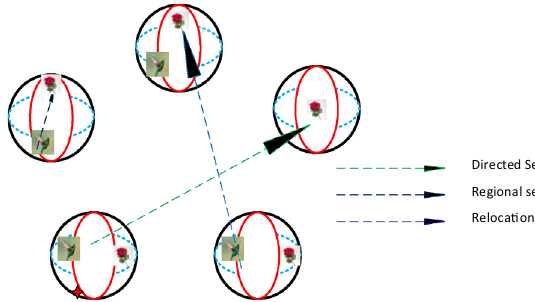
Figure 2. AHO food search classification